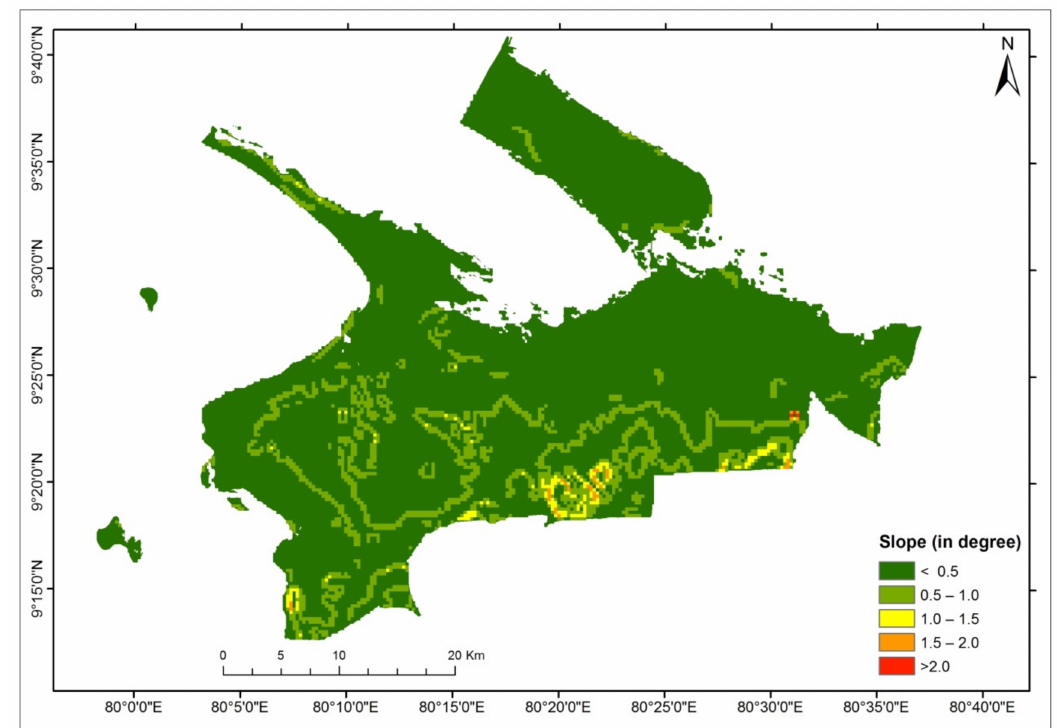
Figure 6. Slope map of Kilinochchi